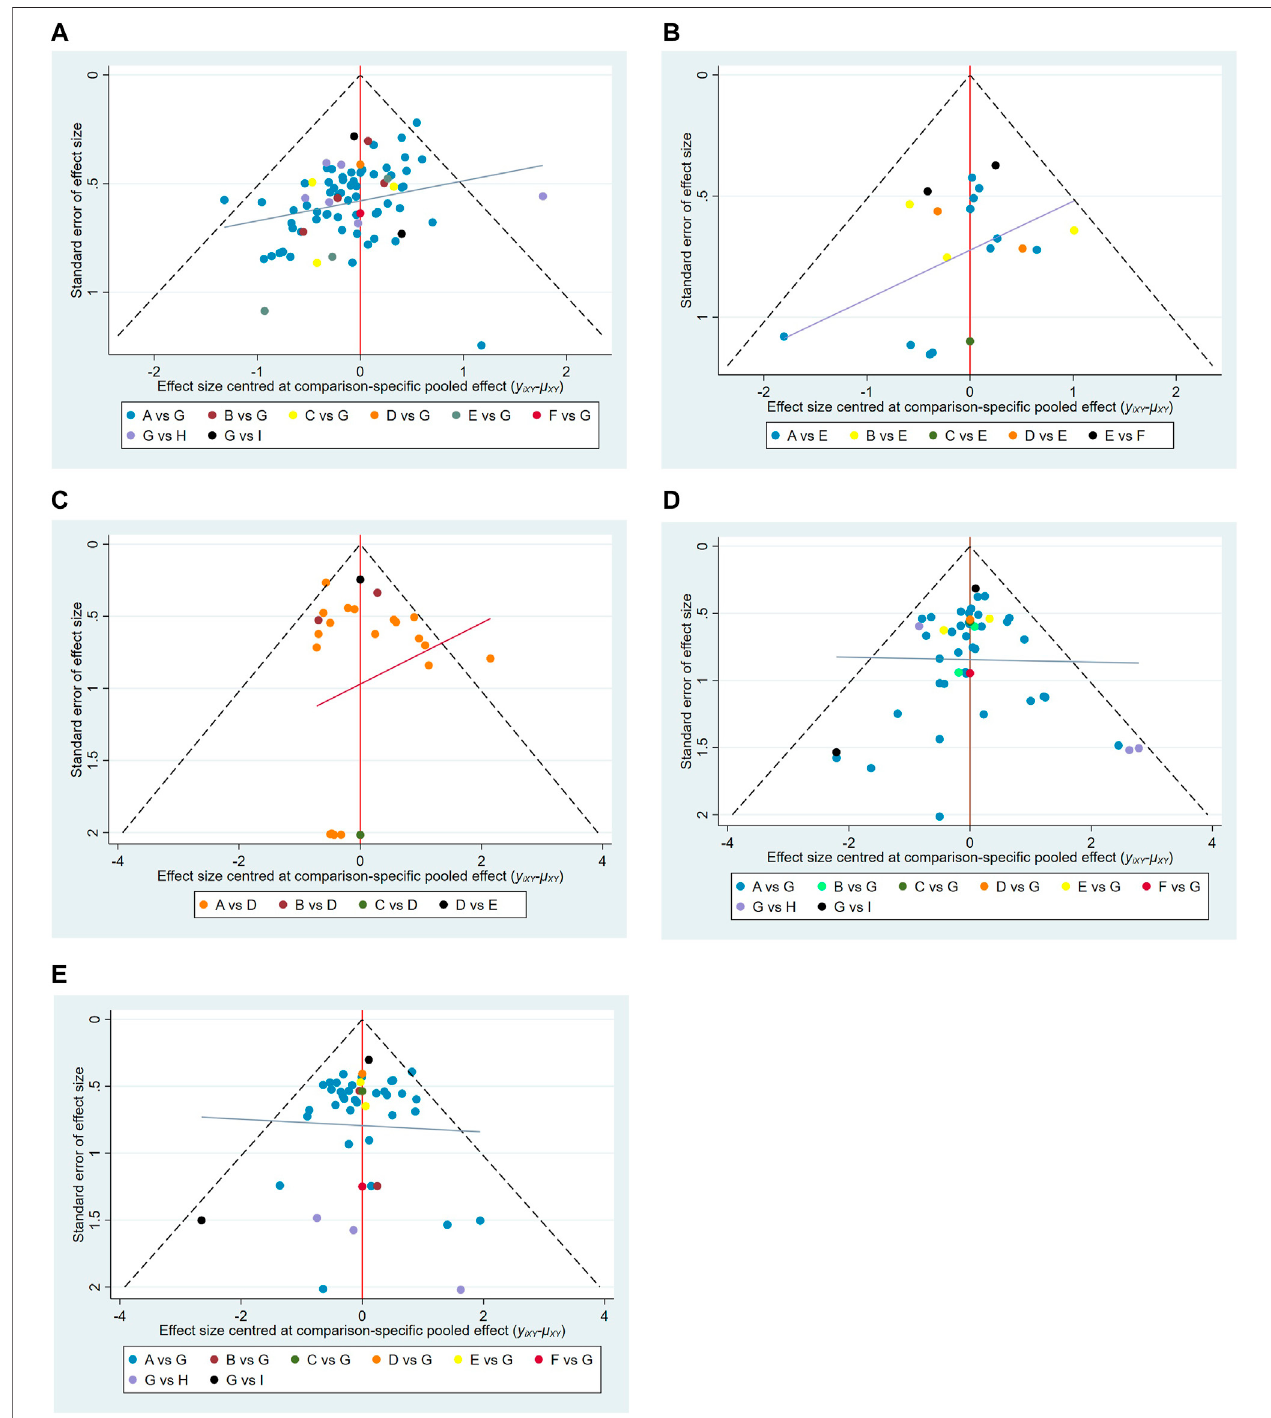
injection+analgesic; G,analgesic; H, Fufangkushen injection; I, Huachansu